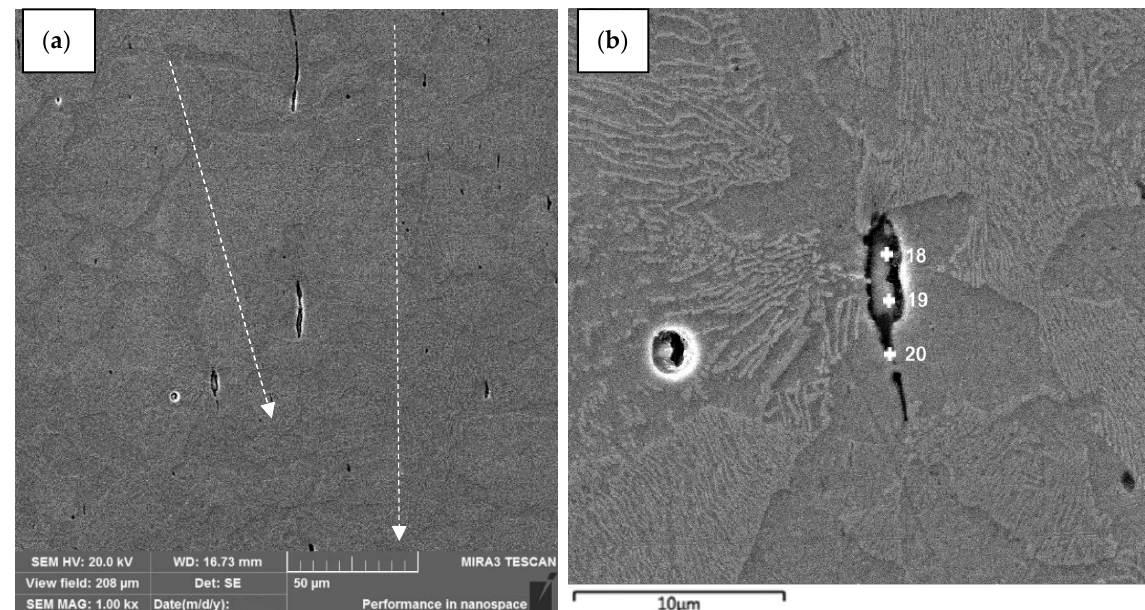
Figure 7. The structure of steel 10 after the dynamic alloying in the SDP mode. Longitudinal direction of the cross-section (along the direction of particle stream: ( a ) Microstructure of steel 10 after the dynamic alloying in the SDP mode with channels(fiber) and ( b ) channel element (fiber) with elemental analysis points. Table 3. Analysis of the composition of the channel element site in steel 10 after dynamic alloying in the SDP mode.